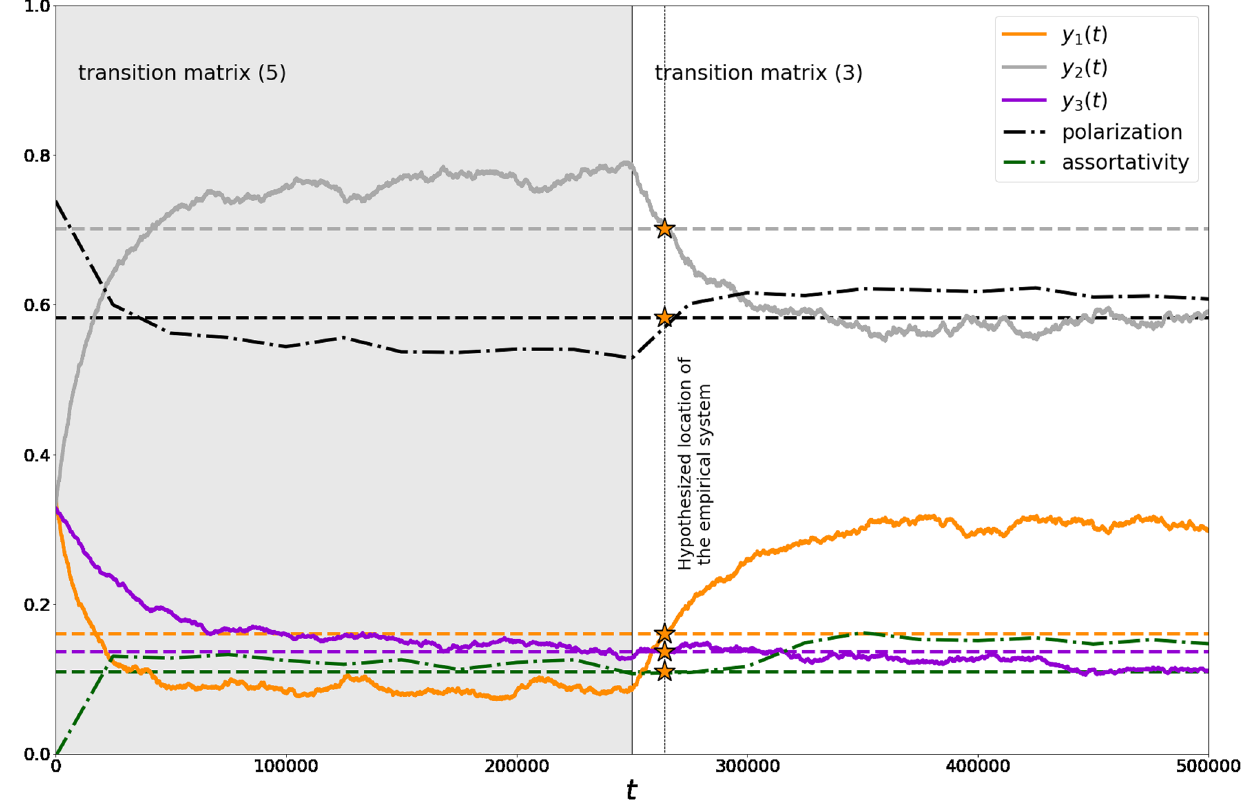
Figure 5. A simulation run for Model 2 if selectivity and personalization are γ = 0.13, δ = 0.1 . Dashed horizontal lines plot reference values from Table 1 (we take values from the first opinion snapshot). Common colors represent the same metrics. Initial opinions are drawn from the uniform distribution y 1 ( 0 ) ≈ 0.33, y 2 ( 0 ) ≈ 0.33, y 3 ( 0 ) ≈ 0.33 . As long as t < 250, 000 , transition matrix (5) is in charge (gray area). At time t = 250, 000 (the edge between gray and white areas), the system is characterized by opinion distribution (6). From this moment, transition matrix (3) governs the opinion dynamics. At time t ≈ 270, 000 (the dashed vertical line), the macroscopic metrics M1 – M3 tend to simultaneously reach reference values (intersections between reference lines and simulation curves are marked roughly with star-like markers). Then, the system moves towards the asymptotic values y ∗ 1 ≈ 0.299, y ∗ 2 ≈ 0.591, y ∗ 3 ≈ 0.111 which differ from mean- field predictions due to the presence of selectivity and